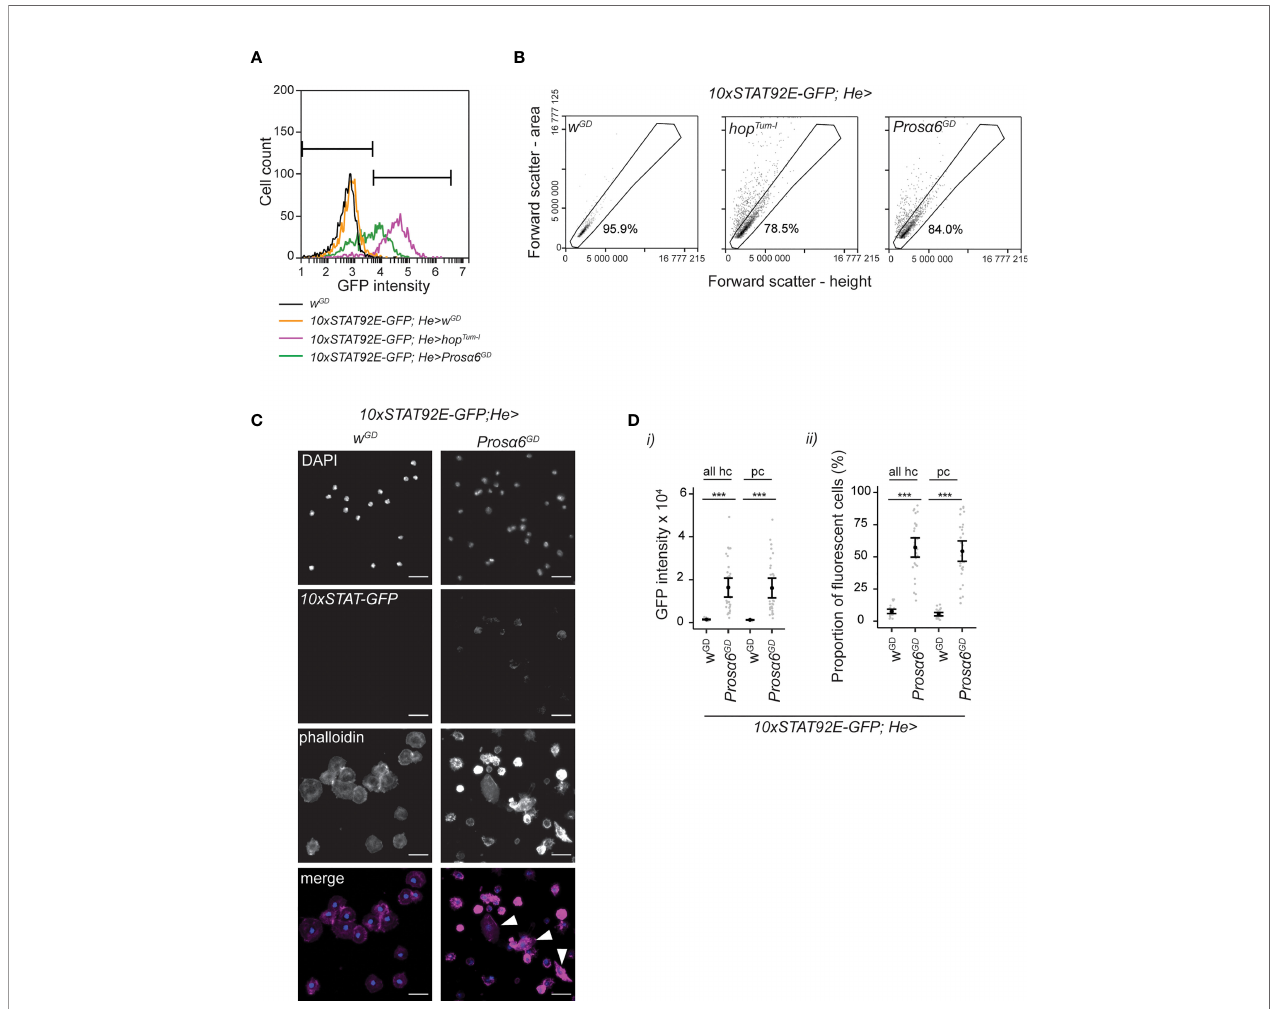
FIGURE 3 | Pros a 6 silencing in hemocytes activates JAK/STAT signaling. (A) Examples of GFP fl uorescence intensity in non- fl uorescent ( w GD , black line), control (orange line), hop Tum-l overexpressing (purple line) and in Pros a 6 knockdown (green line) hemocytes. Note that in the fi gures the symbol “ > “ denotes the presence of the GAL4/UAS system. The genotypes for control, hop Tum-l overexpressing and Pros a 6 knockdown animals are 10xSTAT92E-GFP;He-GAL4/w GD , 10xSTAT92E- GFP;He-GAL4/UAS-hop Tum-l and 10xSTAT92E-GFP;He-GAL4/UAS-Pros a 6 GD , respectively. Bars mark GFP-negative (on the left) and GFP-positive (on the right) areas. (B) Hemocytes detected in 10xSTAT92E-GFP;He-GAL4/w GD , 10xSTAT92E-GFP;He-GAL4/UAS-hop Tum-l and 10xSTAT92E-GFP;He-GAL4/UAS-Pros a 6 GD animals in forward scatter area vs . height plot. While in the controls ( w GD ) most cells resided at a 45° angle in the area vs. height plot, the Pros a 6 knockdown and hop Tum-l overexpressing animals had hemocytes deviating from this area. Gated area represents hemocytes that are considered round (mainly non-activated plasmatocytes). Percentages represent the hemocytes falling into this gate in these example plots. 822 control, 2119 hop Tum-l overexpression and 1857 Pros a 6 knockdown cells were analyzed for (A, B) . (C) Fluorescence microscopy of hemocytes from the control and Pros a 6 knockdown larvae expressing the 10xSTAT-GFP and stained with the nuclear stain DAPI and the F-actin stain Phalloidin. Hemocytes with lamellocyte morphology (marked with arrowheads) were found in Pros a 6 knockdown larvae but not in controls. Of note, DAPI staining appears dimmer in the Pros a 6 knockdown sample, but this was likely due to slide-to-slide